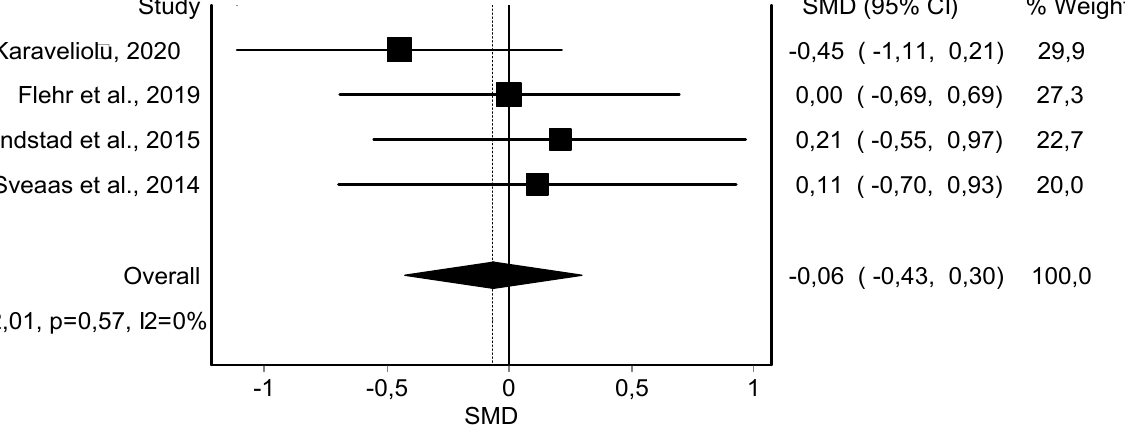
Figure 1. Synthesis forest plot of resting heart rate variable. If the diagram (diamond-shaped) is in the negative zone (on the left of the figure and without touching the 0 line), it indicates statistically significant differences in favor of the HIIT intervention. The forest plot summarizes the results of included studies (standardized mean differences [SMDs], and weight). The small boxes with squares represent the point estimate of the effect size and sample size. The lines on either side of the box represent a 95% confidence interval (CI).